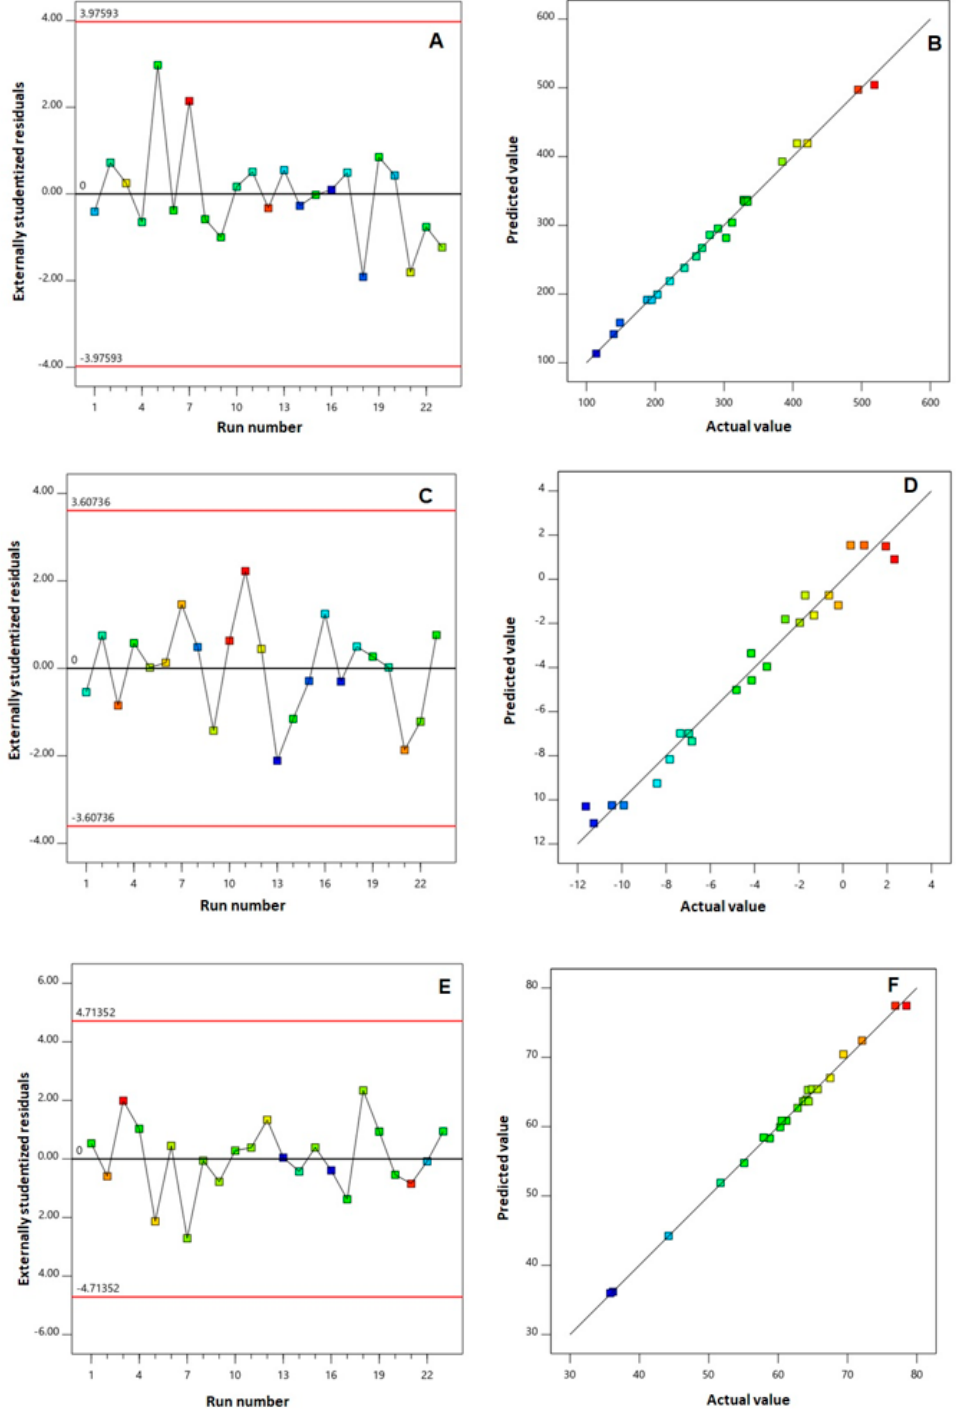
Figure 1. Diagnostic plots for ICA–tocozeinolate nanosphere size ( A , B ), zeta potential ( C , D ), and EE% ( E , F ) for the measured responses of ICA–tocozeinolate nanospheres. Externally studentized residuals vs. run number plot ( A , C , E ) and ( B , D , F ) normal probability